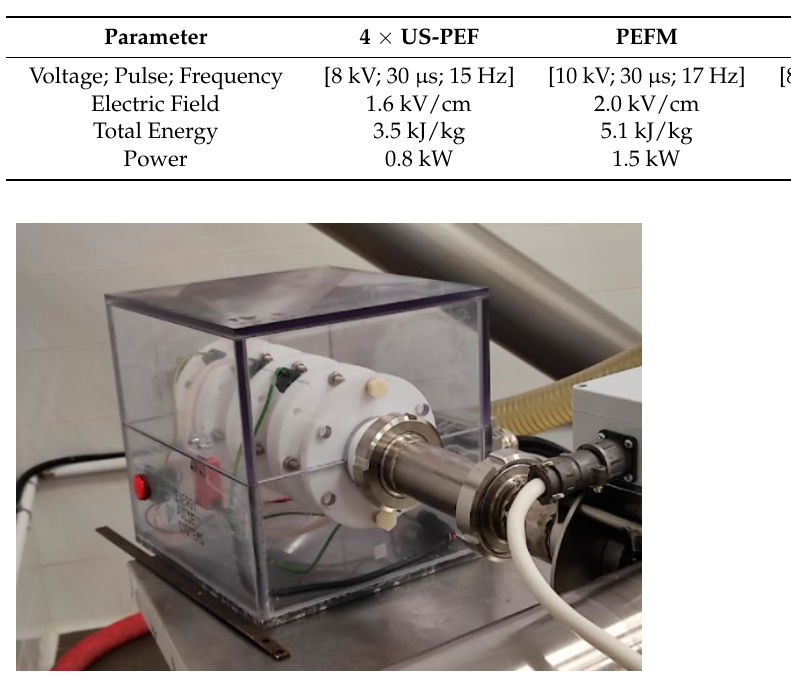
Figure 2. PEF chamber.